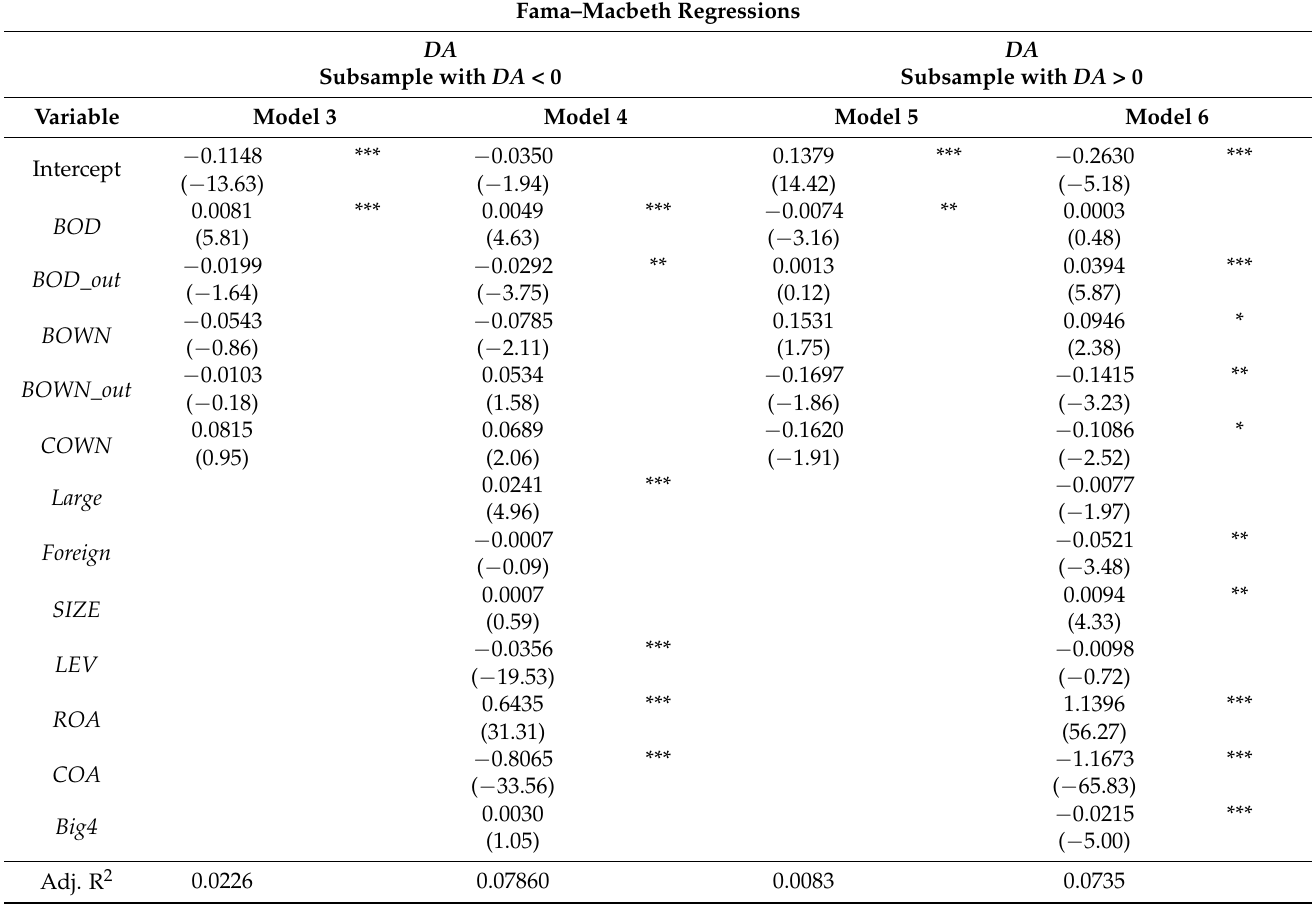
Table 4. Board structure and discretionary